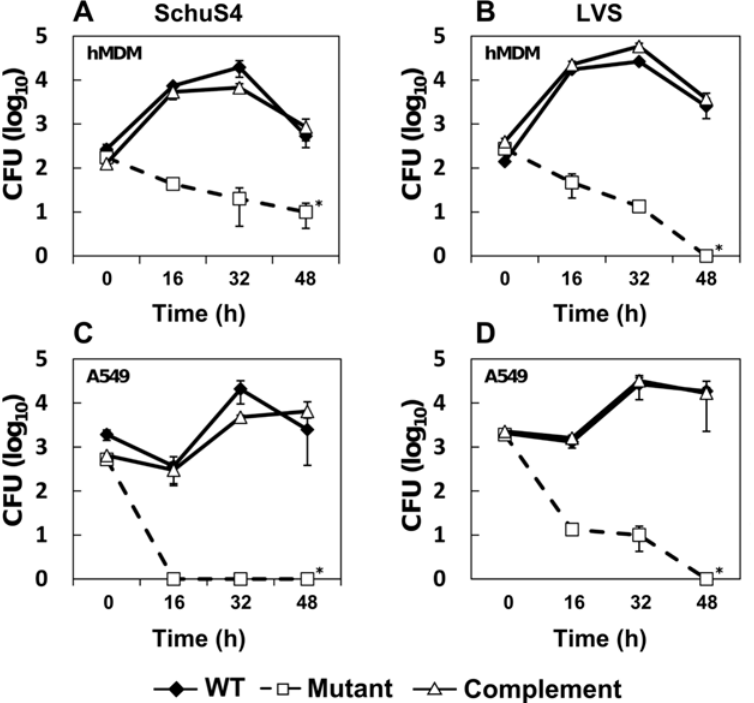
Figure 1. Growth of F.tularensis derivatives in mammalian cells. Intracellular growth of F. tularensis Schu S4 and LVS derivatives in human monocyte-derived macrophages (A and B), and A549 lung epithelial cells (C and D). Cells were infected with wild type F. tularensis LVS or Schu S4, LVS or Schu S4 D purMCD , or the LVS or Schu S4 genetically complemented D purMCD , and intracellular growth was monitored by lysing cells at the indicated time points and determining CFU by standard plate count. Infections were conducted at an MOI of 1, and gentamicin (5 m g/ml) was added to culture medium after infection to kill extracellular organisms. Standard errors of organ burden from three individual mice are shown. Asterisks indicate significance between wild-type or complemented D purMCD mutants and D purMCD burdens ( P , 0.05; two-way ANOVA).